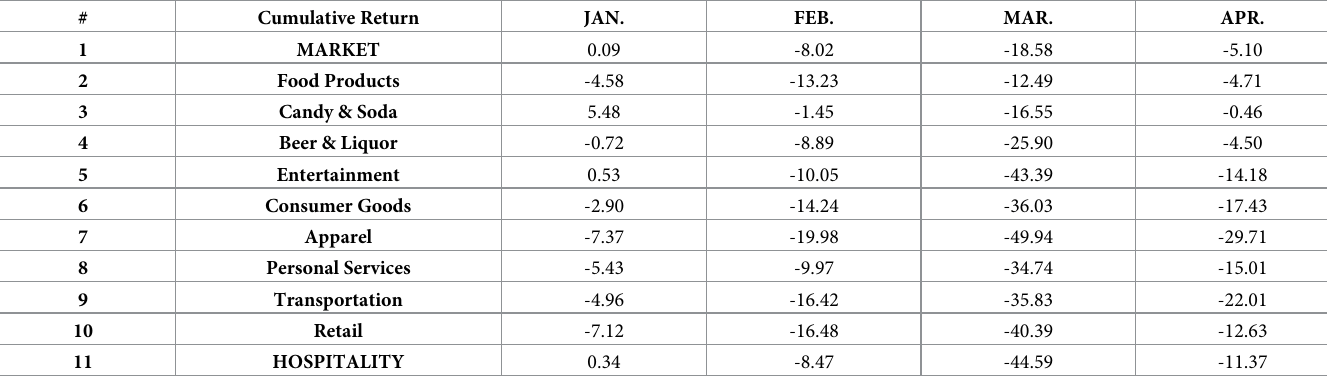
Table 1. The performance of U.S. hospitality stocks and those in closely related industries during